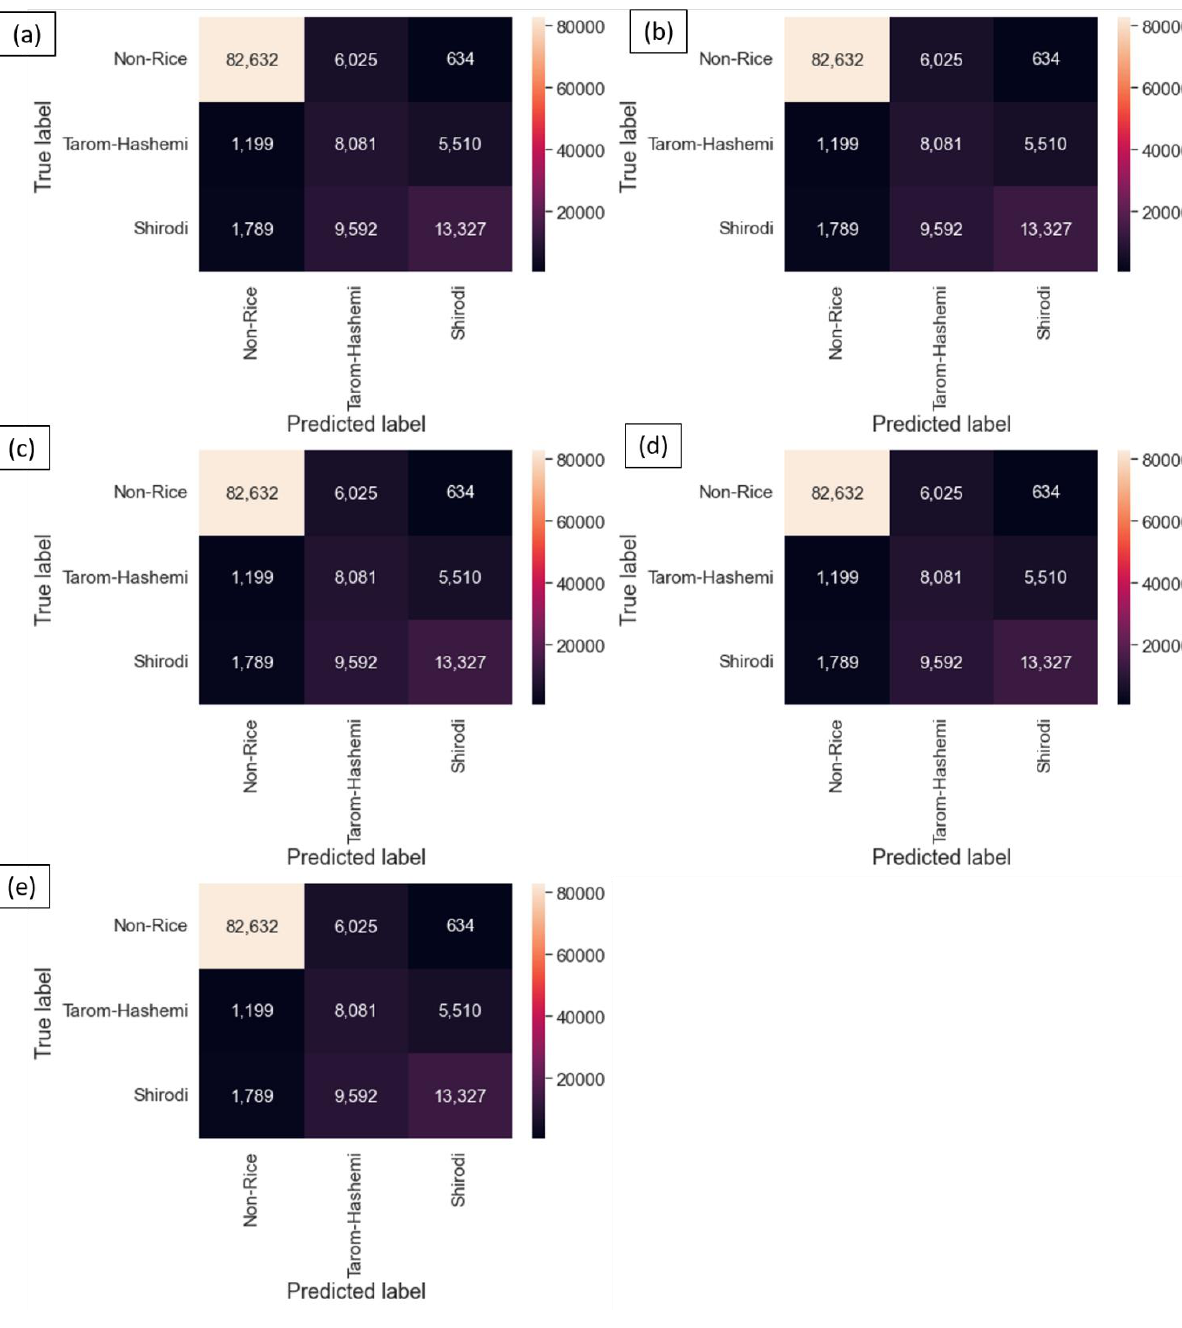
Figure 10. Comparison of confusion matrices for different rice-type mapping methods: ( a ) RF, ( b ) XGBoost, ( c ) 2D-CNN, ( d ) 3D-CNN, and ( e ) the proposed method.